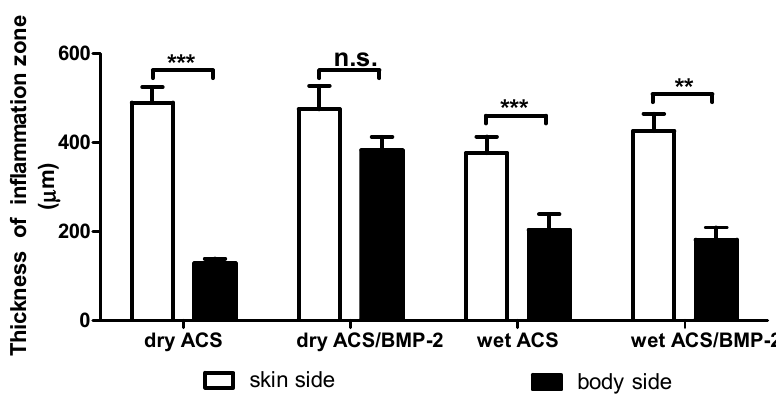
Figure 4. Comparison of the mean thickness of the inflammation zone on the skin side and the body side. There are significant differences in the thickness of the inflammatory zones between the skin side and the lumbar body side in the dry ACS implant group without BMP-2, and in both the wet ACS groups with or without BMP-2. **: p < 0.01, ***: p < 0.001, n.s.: no significant difference.